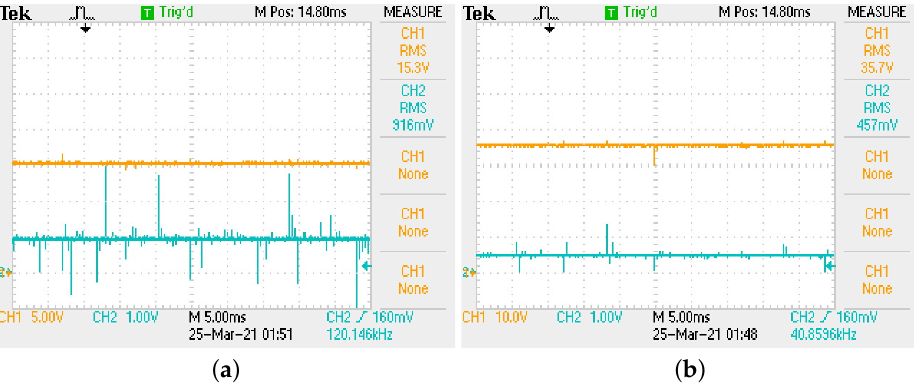
Figure 12. ( a ) Regulation to V o = 15 V in buck mode. ( b ) Regulation to V o = 35 V in boost mode.